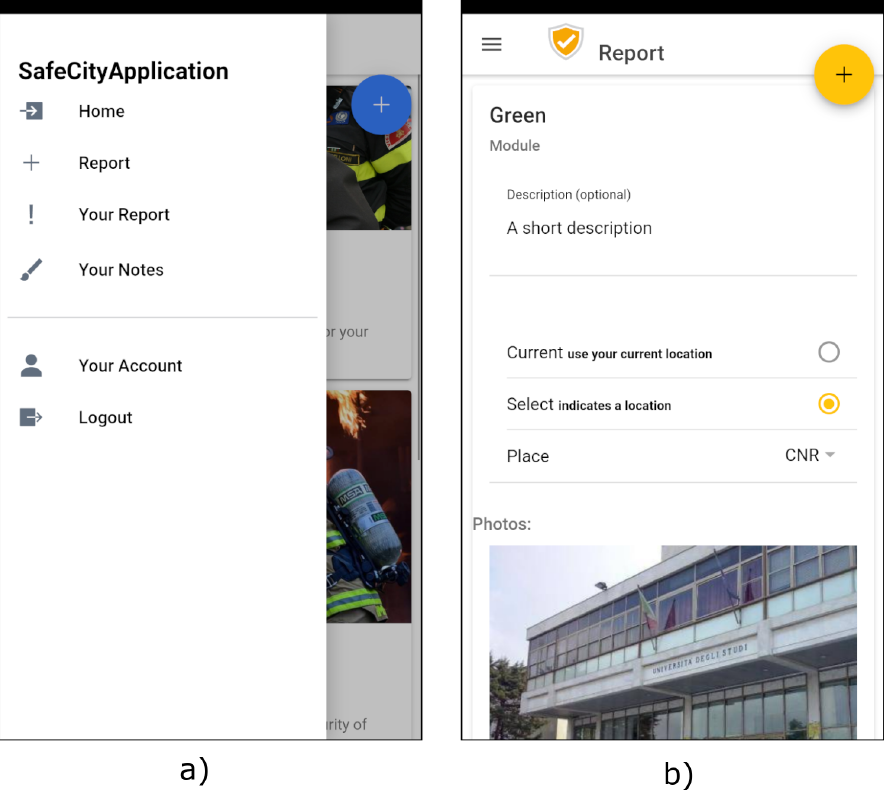
Figure 3. Screenshots of the Mobile Application. The menu of the application ( a ); the form used by the user to report a problem ( b ).